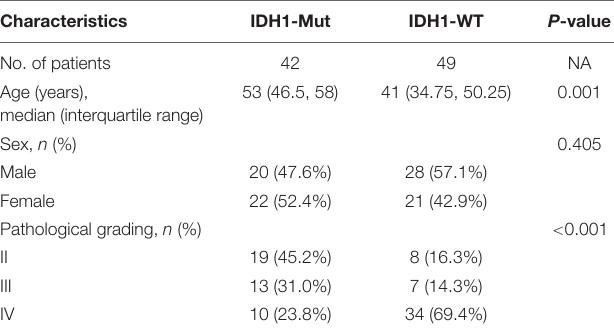
TABLE 1 | Patient characteristics and